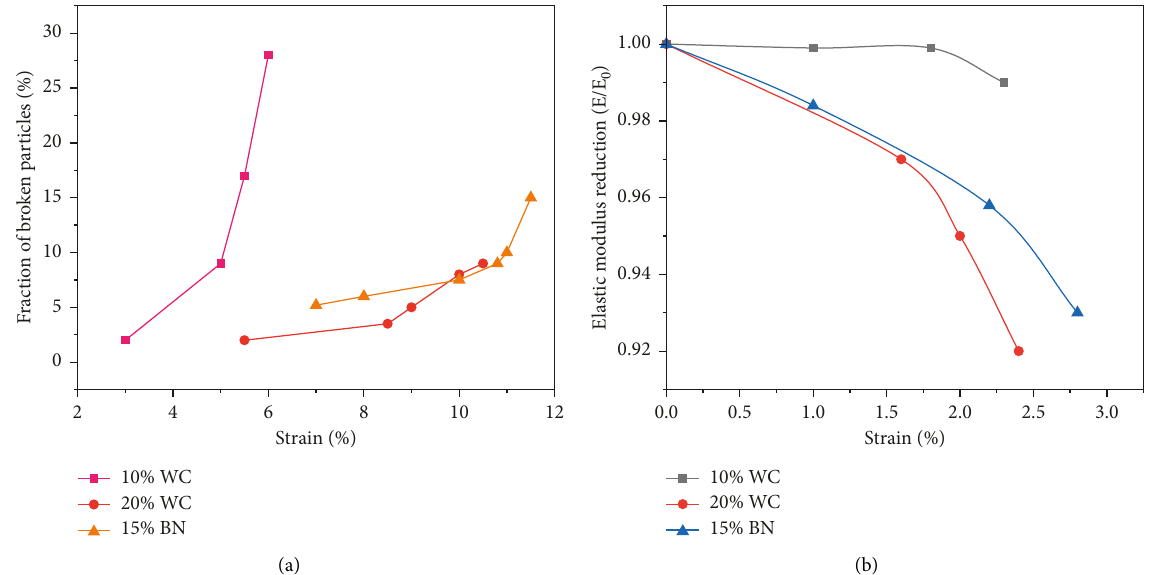
Figure 5: Damage evolution in the composites under T4 heat treatments during tensile straining shown by two ways: (a) by the fraction of broken elements as a function of tensile strains and (b) by elastic modulus reduction normalised by the modulus at zero strain during tensile